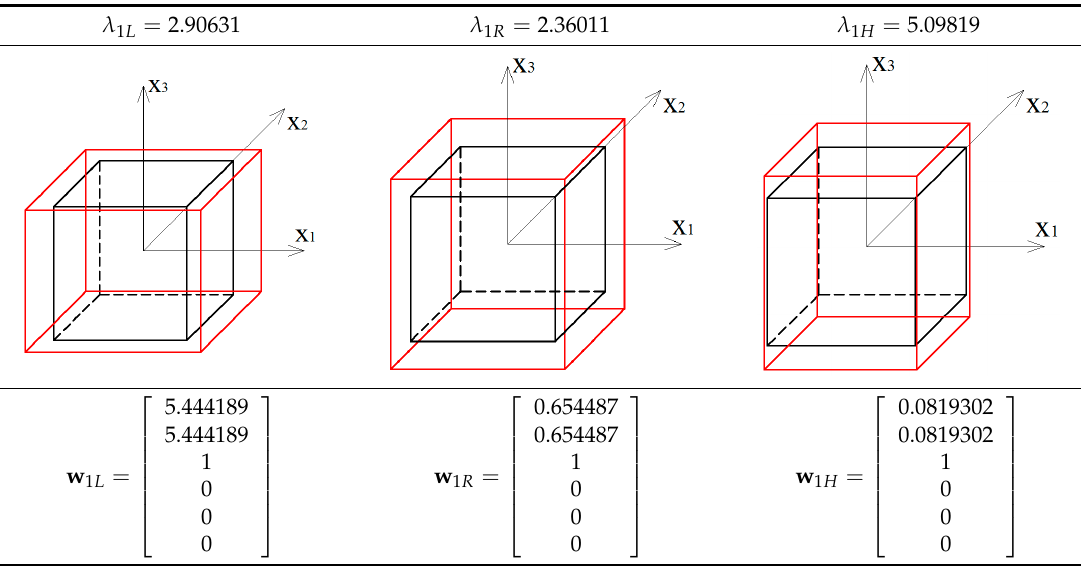
Table 1. Stiff (extensional) mode of deformation.